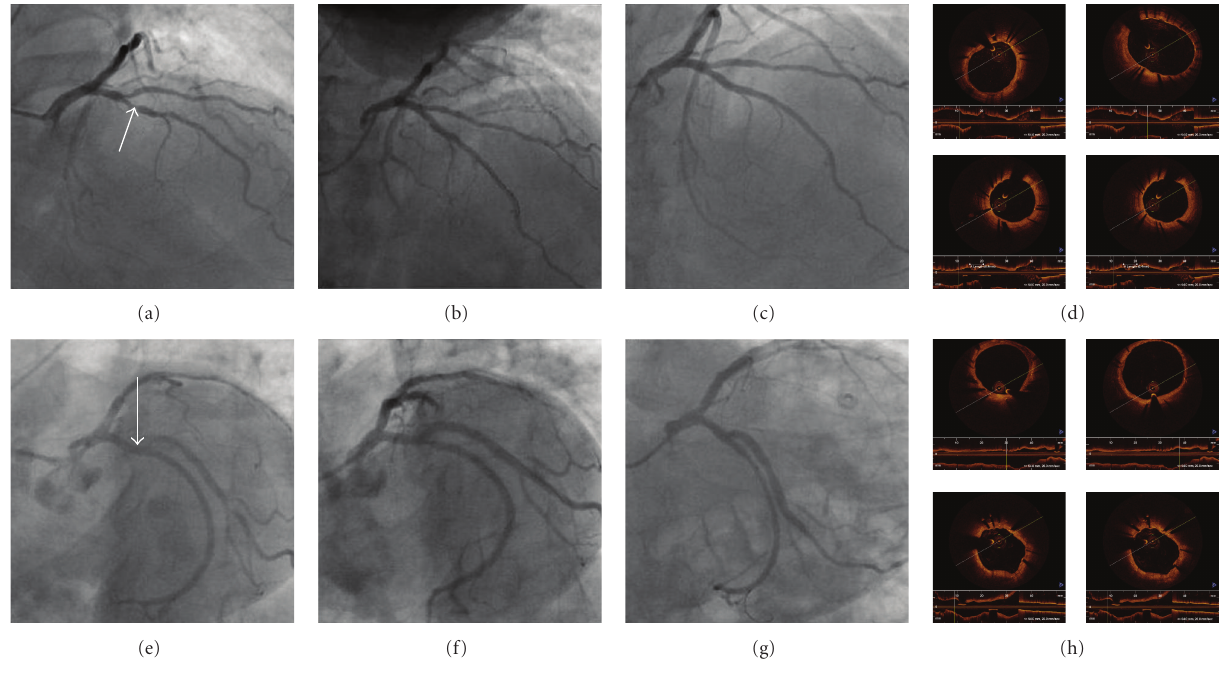
Figure 1: Upper panel shows the left coronary angiogram in the standard right anterior oblique cranial view. (a) At baseline, anterior descending artery (LAD) demonstrates a critical stenosis involving the origin of the first diagonal branch. (b) After two stents implantation in a “t and small protrusion”(TAP) fashion, good angiographic result can be seen. (c) One year angiographic followup attests that good result is maintained. (d) optical coherence tomography (OCT) analysisof LAD and diagonalbranch (4 representative slices)at one year showsgood neointimal coverage of the stent struts, without “malapposition”. Lower panel shows the left coronary angiogram in the standard left anterior oblique view. (e) At baseline, critical stenosis of the circumflex artery (LCX) at the level of the first marginal branch is visible. (f) After two stents implantationin a “culotte” fashion,good angiographicresult can be seen. (g) One year angiographicfollowup testifies the maintenance of good angiographic result. (h) optical coherence tomography (OCT) analysis of LAD and diagonal branch (4 representative slices) at one year shows good neointimal coverage of the stent struts, without